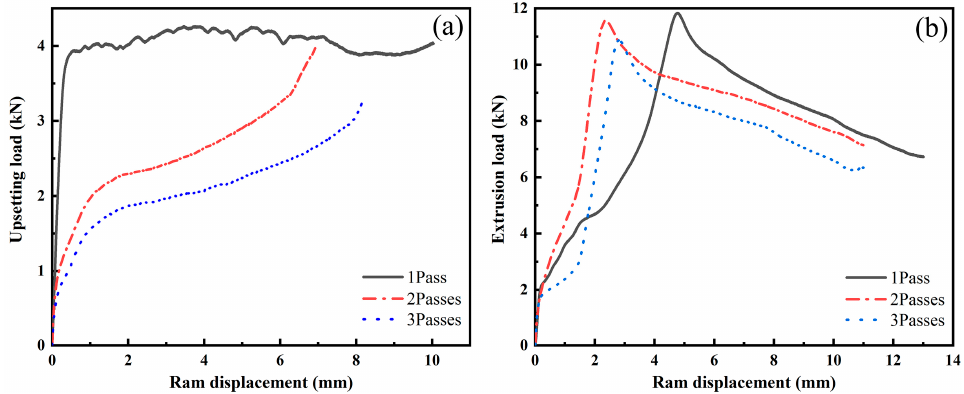
Figure 6. Load-displacement curves for individual: ( a ) upsetting; and ( b ) extrusion processes corresponding to one, two, and three passes, respectively.